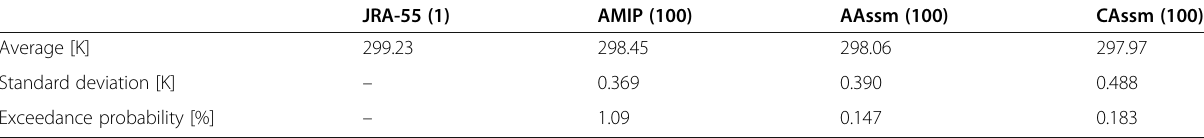
Table 4 Averages and standard deviations of SAT JP for August 2010, and exceedance probabilities over Δ SAT JP in JRA-55 for August 2010 in AMIP, AAssm, and CAssm experiments. Numbers in parentheses represent the number of samples for August 2010